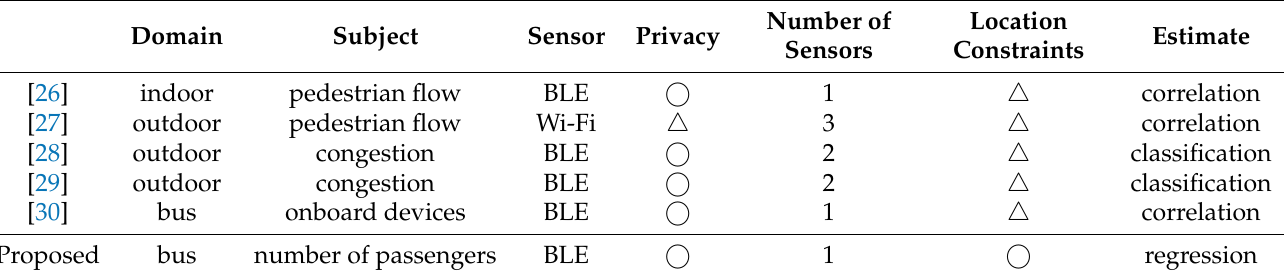
Table 1. Comparison table between related work and proposed